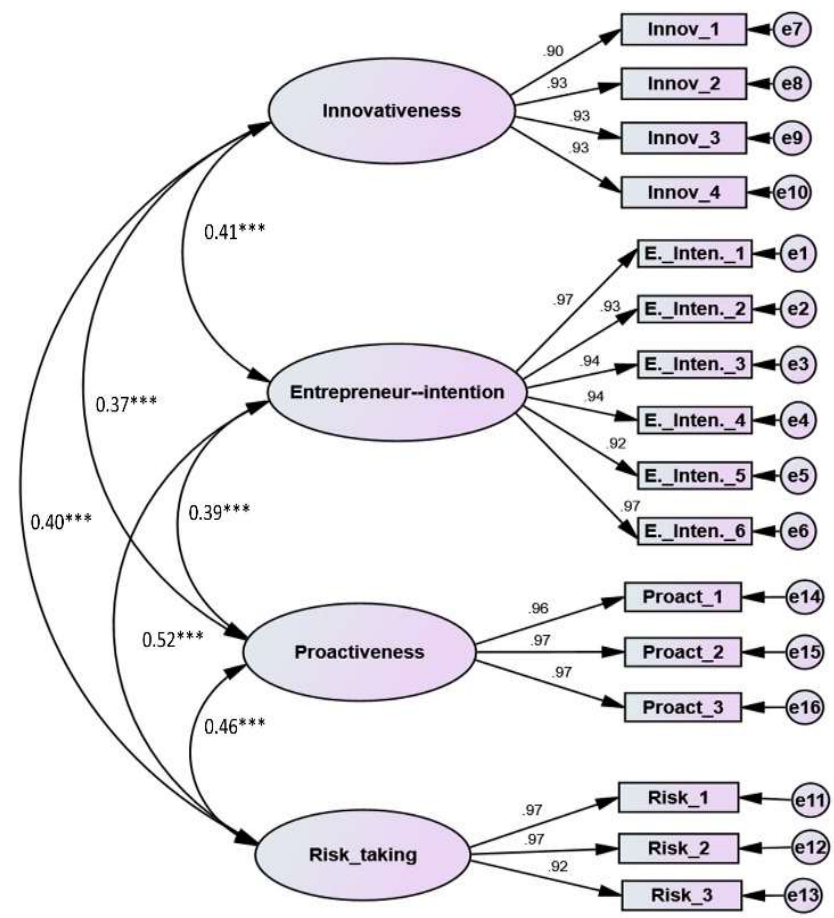
Figure 2. The CFA Model. Note: ***: significant level below 0.001.